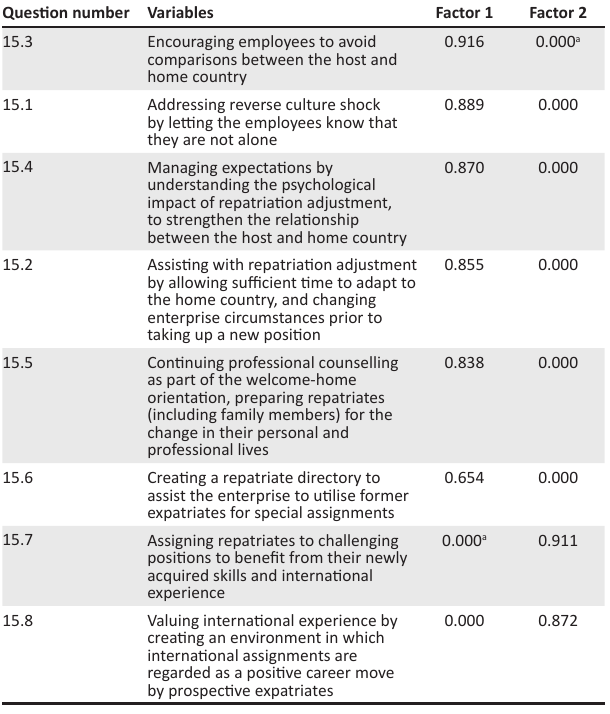
TABLE 8: Factor matrix with sorted rotated factor loadings.